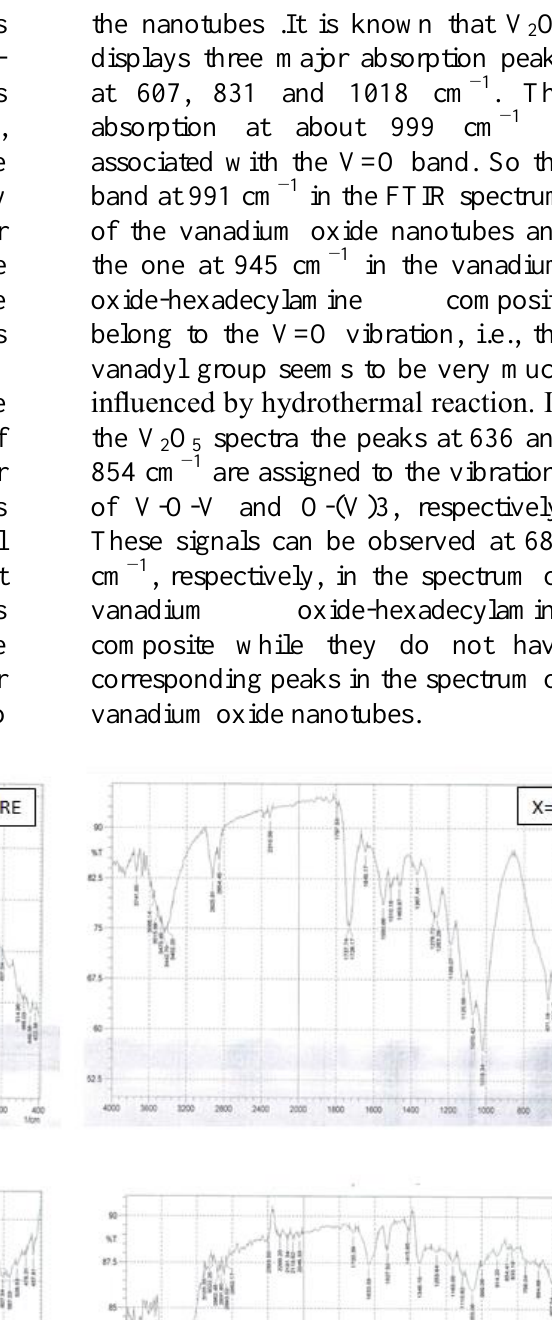
content (x =0, 0.1, 2